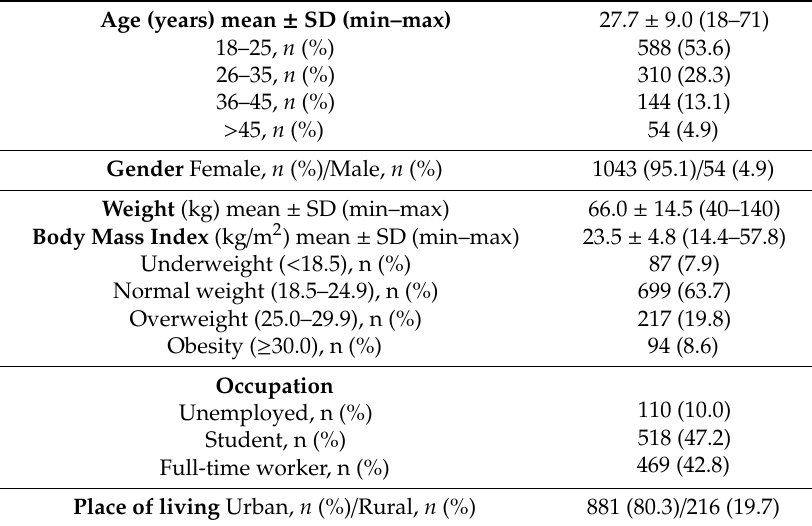
Table 1. Demographic breakdown of surveyed participants ( n =